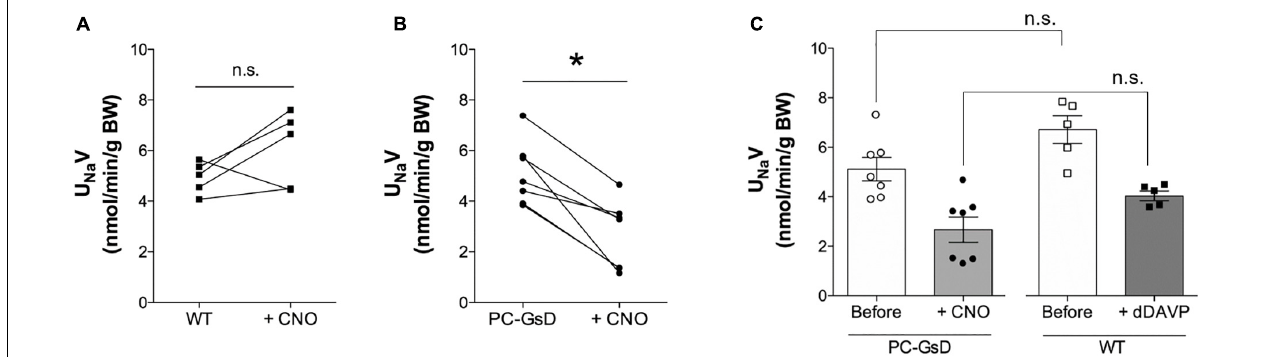
FIGURE 5 | CNO increases urinary Na + excretion in PC-specific GsD mice. Summary graphs from paired experiments showing 24 h urinary Na + excretion (U Na V) before and after treatment with CNO (0.1 mg/kg) in wild type littermate controls ( A , n = 5) and PC-specific GsD mice ( B , n = 7). * P < 0.05 vs. before treatment. (C) Summary graph of 24 h urinary Na + excretion before (white circles, white bar) and after (black circles, gray bar) CNO treatment for PC-specific GsD mice, and control mice before (white boxes, white bar) and after (black boxes, dark gray bar) dDAVP treatment (1.0 mg/100 ml; n = 5).